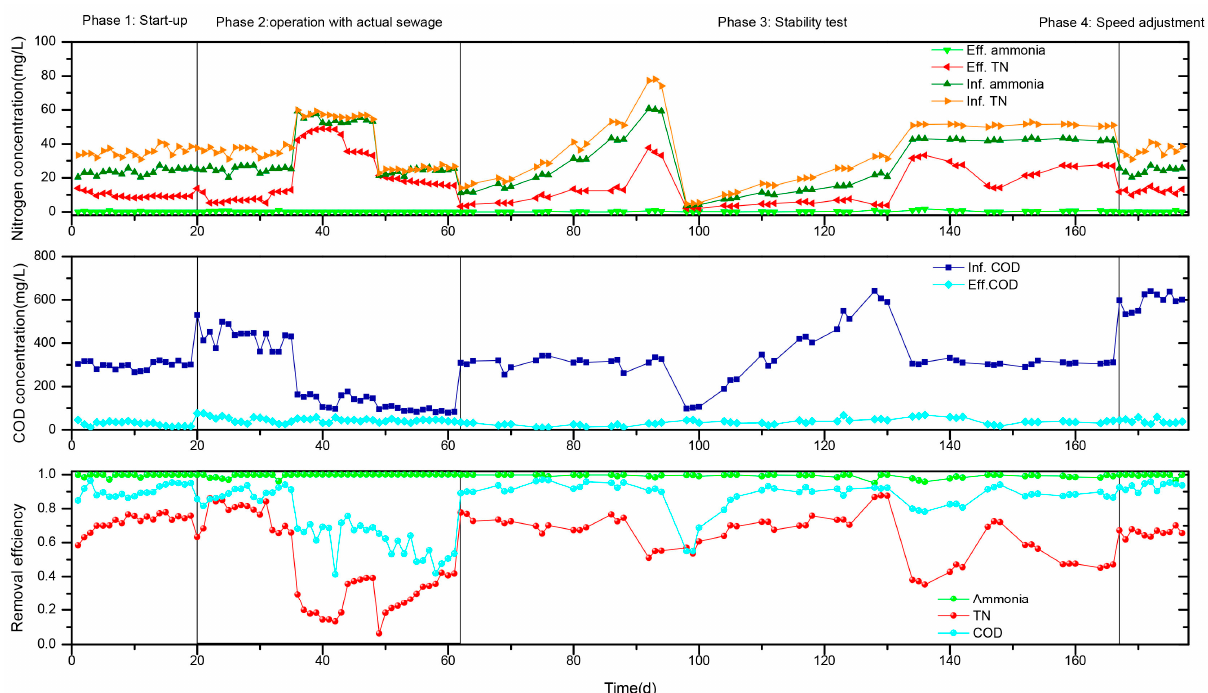
Figure 1. Removal performances of the WRBC system.